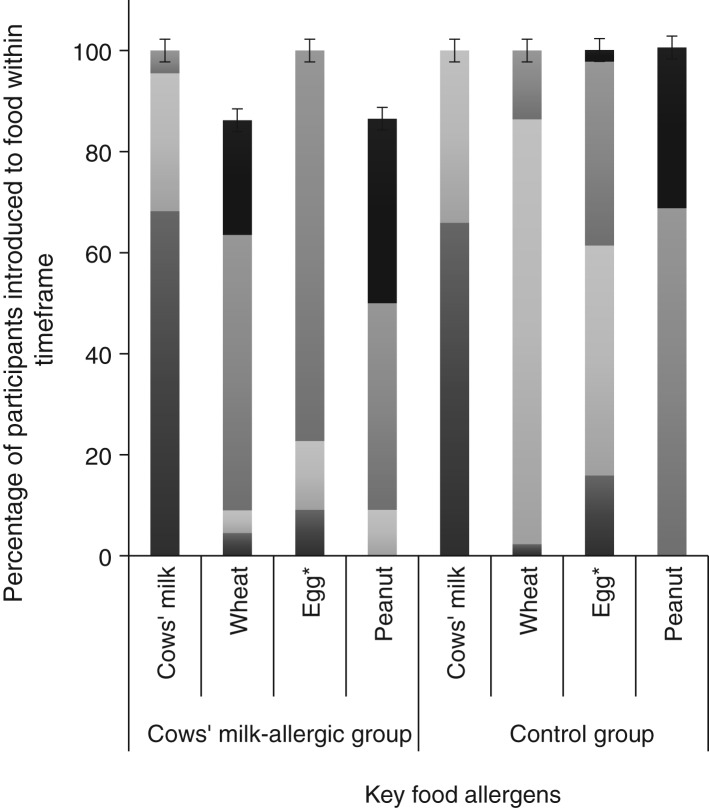
Timing of introduction of key food allergens to cows’ milk-allergic (n 22) and control groups (n 44). *Significantly different between groups using Fisher's exact test (P = 0·012). , 9–12 months; , 6–9 months; , 3–6 months; , < 3 months. The error bars indicate 95 % confidence intervals.